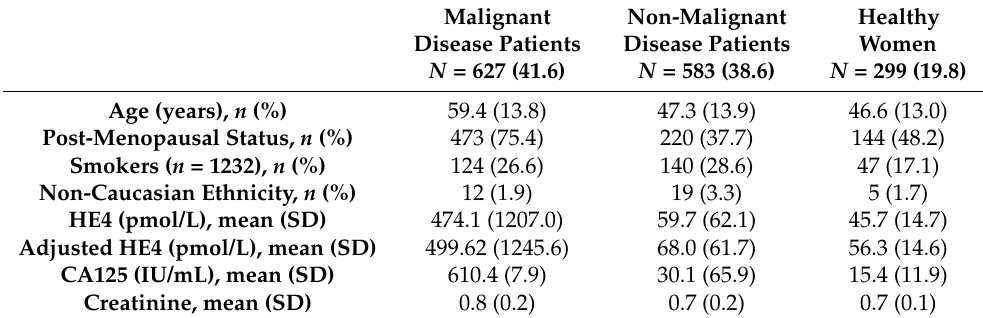
Table 1. Biochemical and physiological properties of the enrolled population. Results are expressed as a number (percentage) or mean (standard deviation); 1232 represents the number of smokers in this female population.